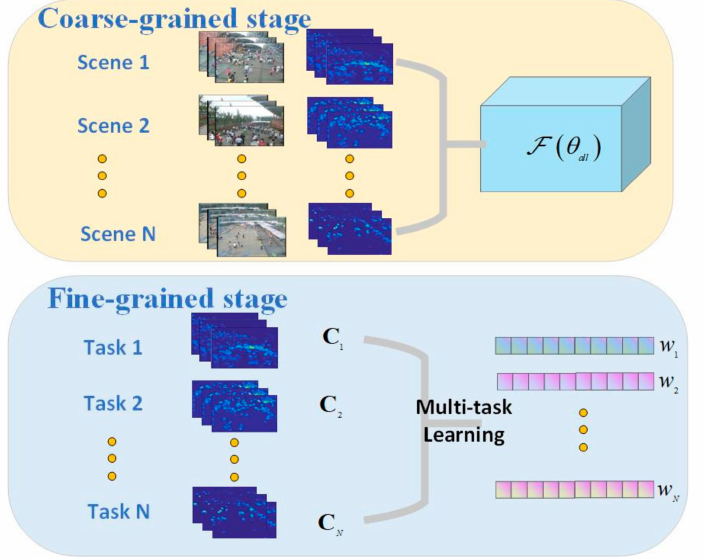
Figure 1. The pipeline of proposed coarse-to-fine multi-scene adaptive crowd counting. At the coarse-grained stage, the frame pairs of multiple known scenes are used to train a generic model with meta-knowledge. At the fine-grained stage, overall counting regression from estimated density maps of each scene is regarded as a specific task. Multi-task learning is used to learn the regression weight of each specific